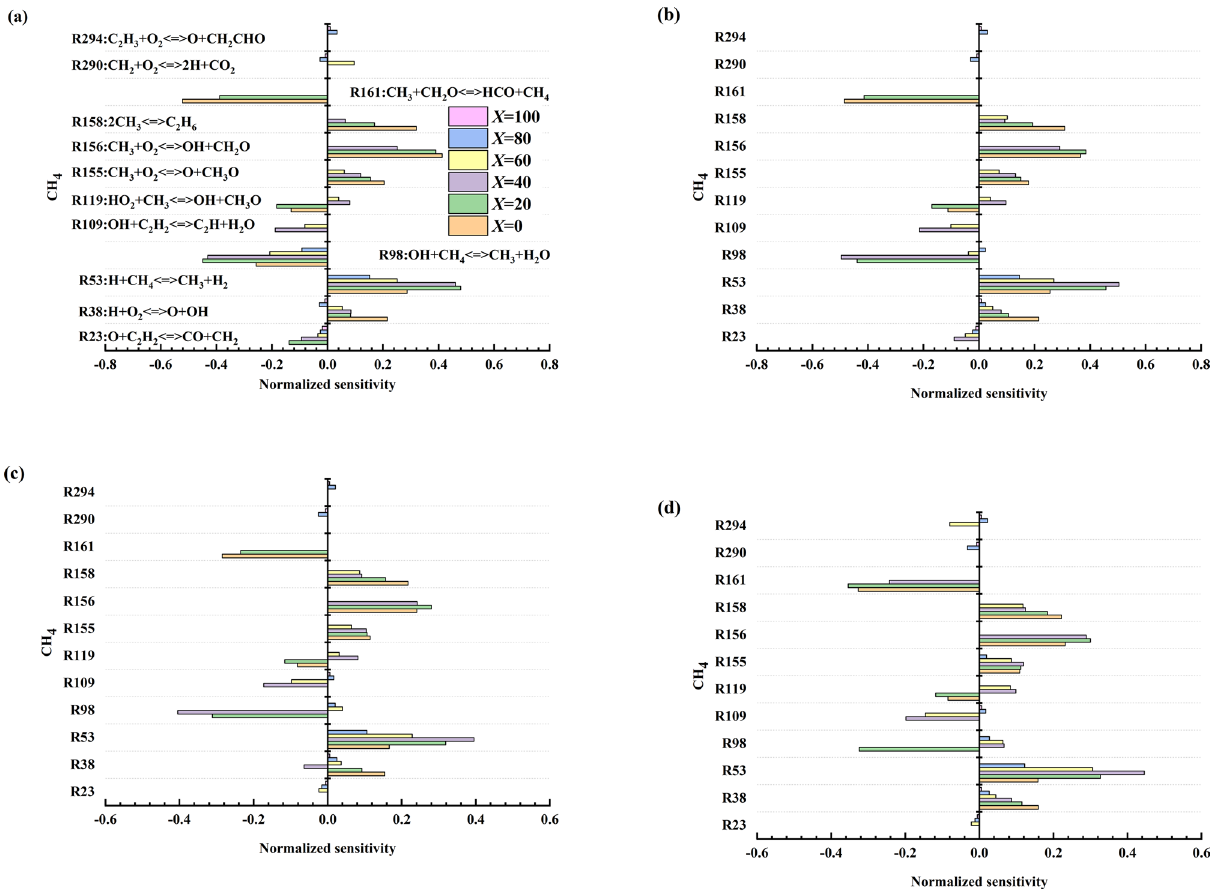
Figure 8. Normalized methane sensitivity coefficients for four equivalent ratios [( a ) Φ = 0.8, ( b ) Φ = 1.0, ( c ) Φ = 1.2, ( d ) Φ = 1.4] during